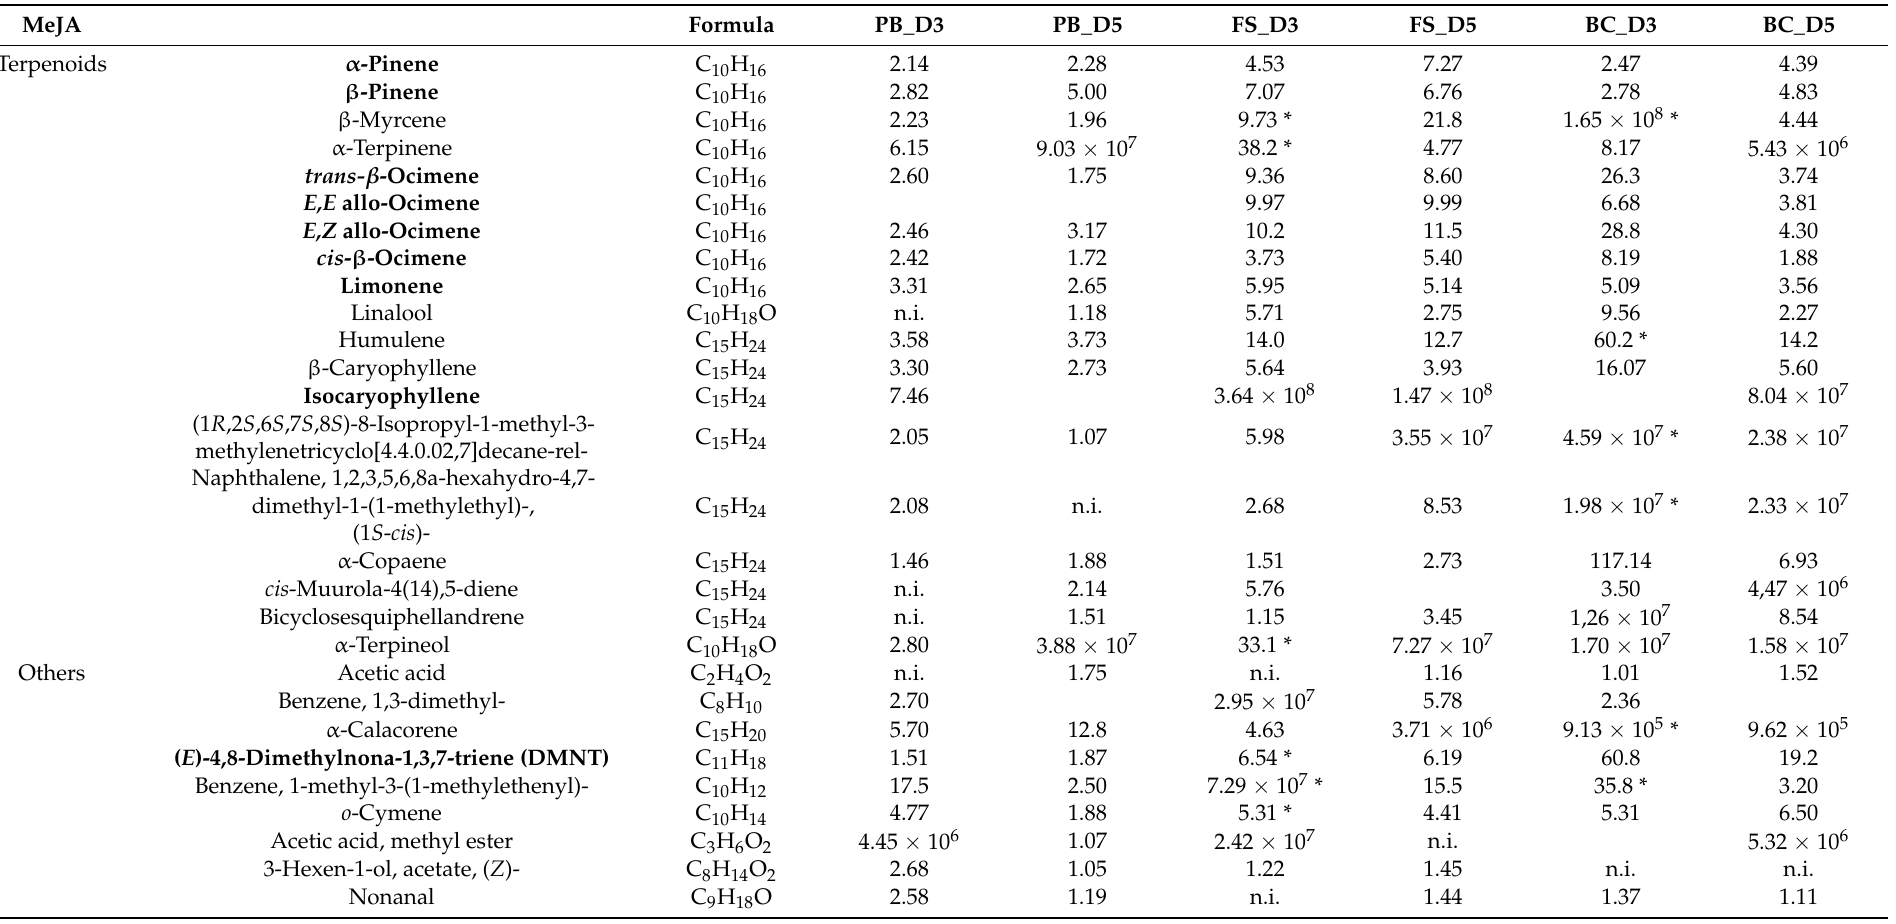
Table 3. MeJA- and CuSO 4 -induced VOCs. Elicitor-induced VOCs were selected at three phenological stages of the grapevines and two time points (BAG mode). VOCs were selected when FC > 1 at least 4 times out of the 6 time points (ca. > 50% of the collected samples). *: Significant t -test (FDR < 0.05) vs. H 2 O control samples. n.i.: not induced. Phenological stages of grapevines: pre-blossom: PB; fruit-set: FS and bunch-closure: BC. Time points: three- and five-days post treatment (D3 and D5). The VOCs in bold type were common to the 3 Bastid ® , MeJA and CuSO 4 treatments.